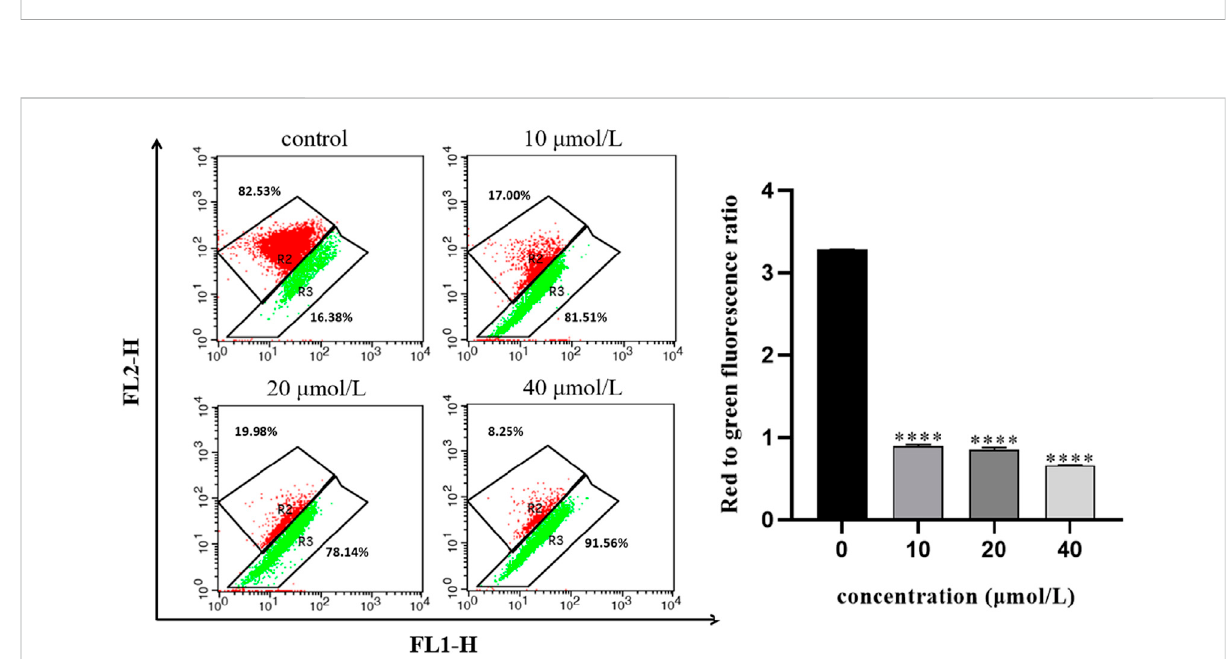
Effect of RFA on the mitochondrial membrane potential of 786-O cells. The mitochondrial membrane potential was presented as the ratio of the red fl uorescence intensity to the green fl uorescence intensity. Data were expressed as mean ± SD. t -test was used for the statistical analysis of the data. **** p < 0.0001, versus the untreated control